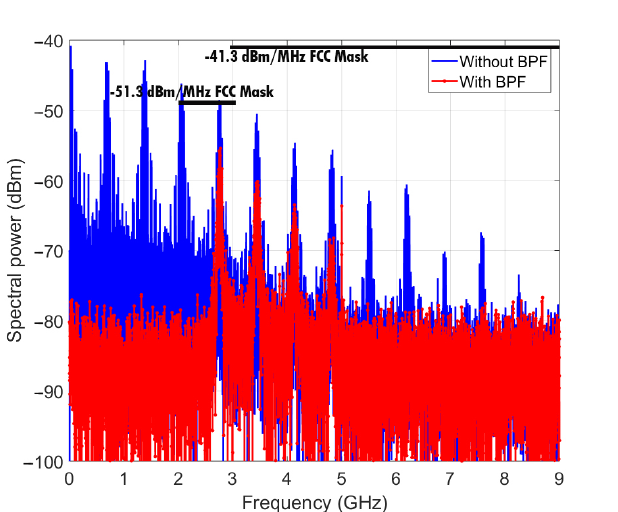
Figure 13. Spectrum of the IR-UWB transmitter before and after bandpass filter at 1.3 V supply voltage. The FCC spectral mask is also shown. The spectrum is computed in the oscilloscope as the FFT of the measured time signal.